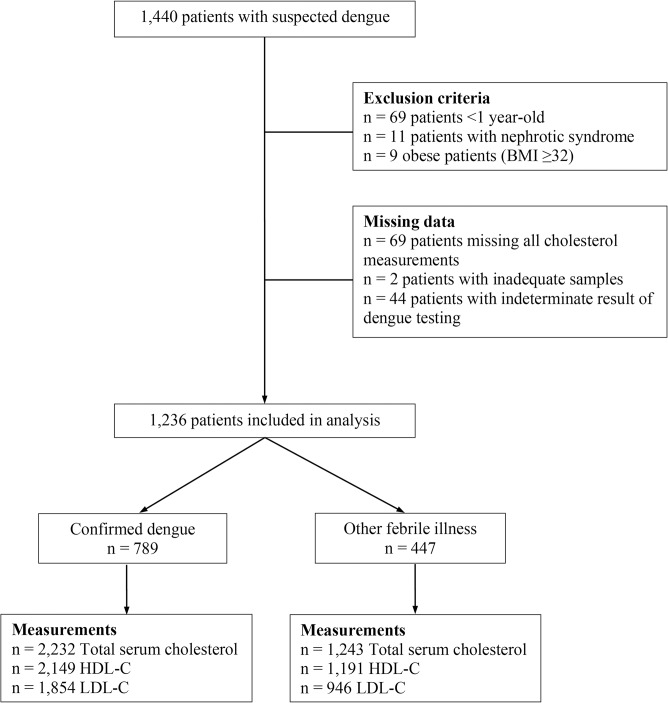
Eligibility flow chart.Of the 1,440 patients who presented to the hospital with suspected dengue, 1,236 met the eligibility criteria and were included in the analysis. Abbreviations: BMI, body mass index.